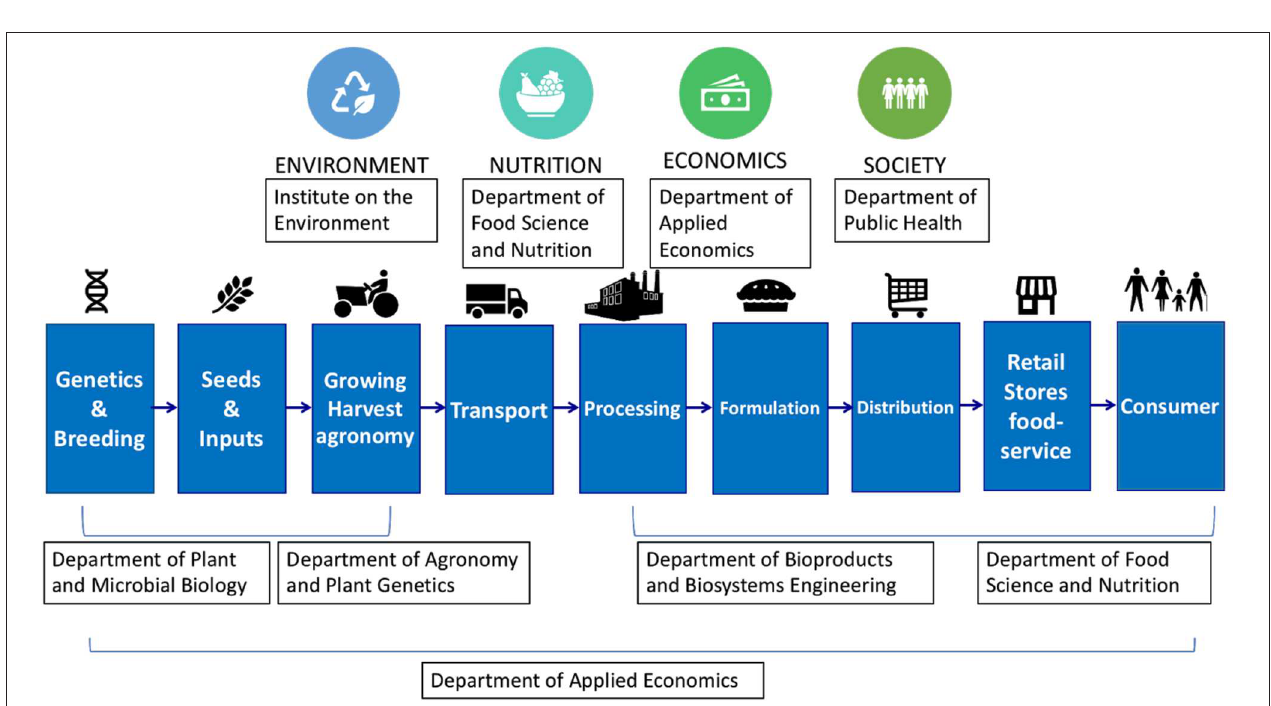
FIGURE 2 | Relationship between value chain actors and the University of Minnesota shows the reciprocal relationships between universities and value chain actors and influencers.